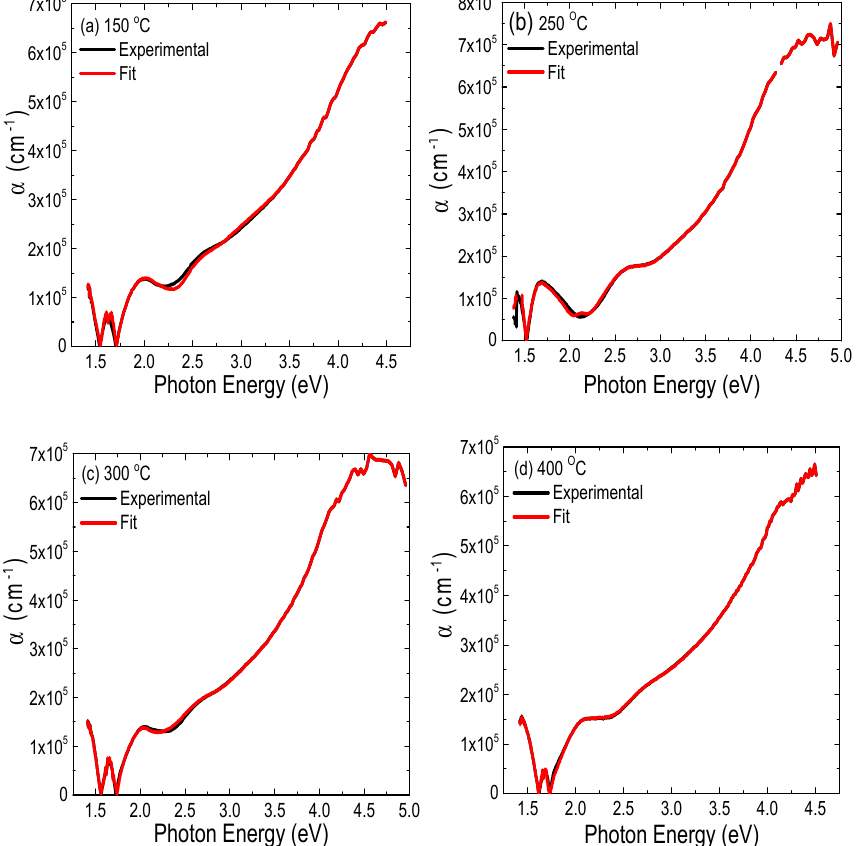
Figure 6. ( a – d ) . The absorption coefficient α vs. photon energy for CdSe thin films deposited at different growth temperatures.